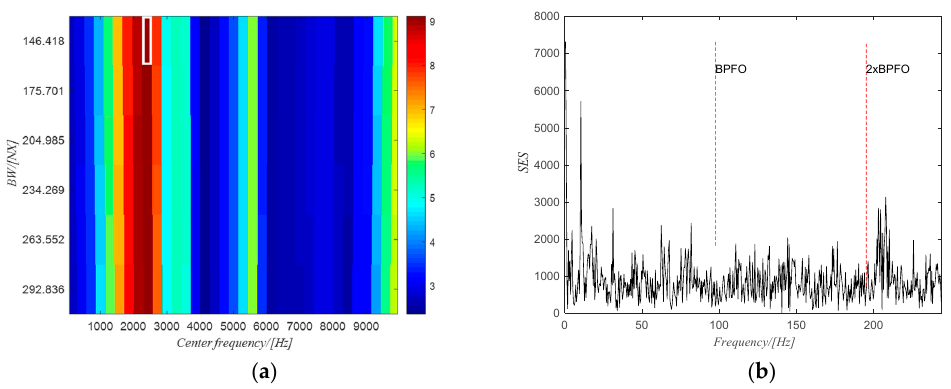
Figure 18. ( a ) The PMFSgram of the resampled signal; ( b ) the SES of the filtered signal.